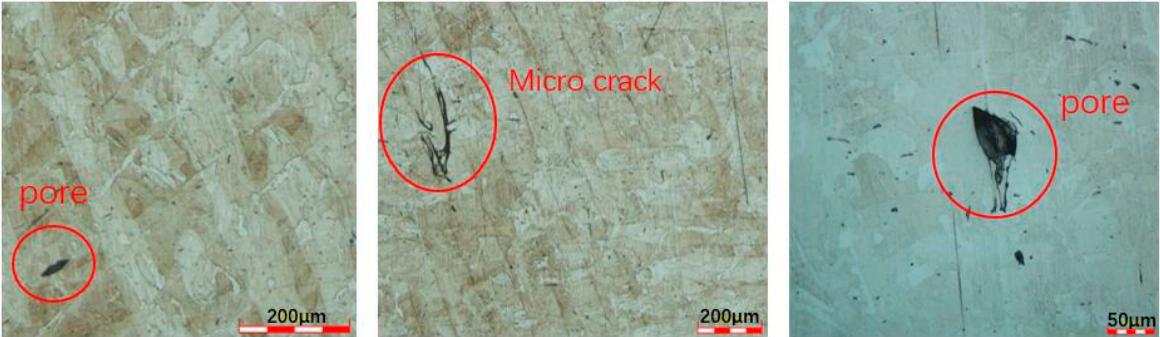
Figure 9. Optical micrograph of pores and microcracks below the surface.